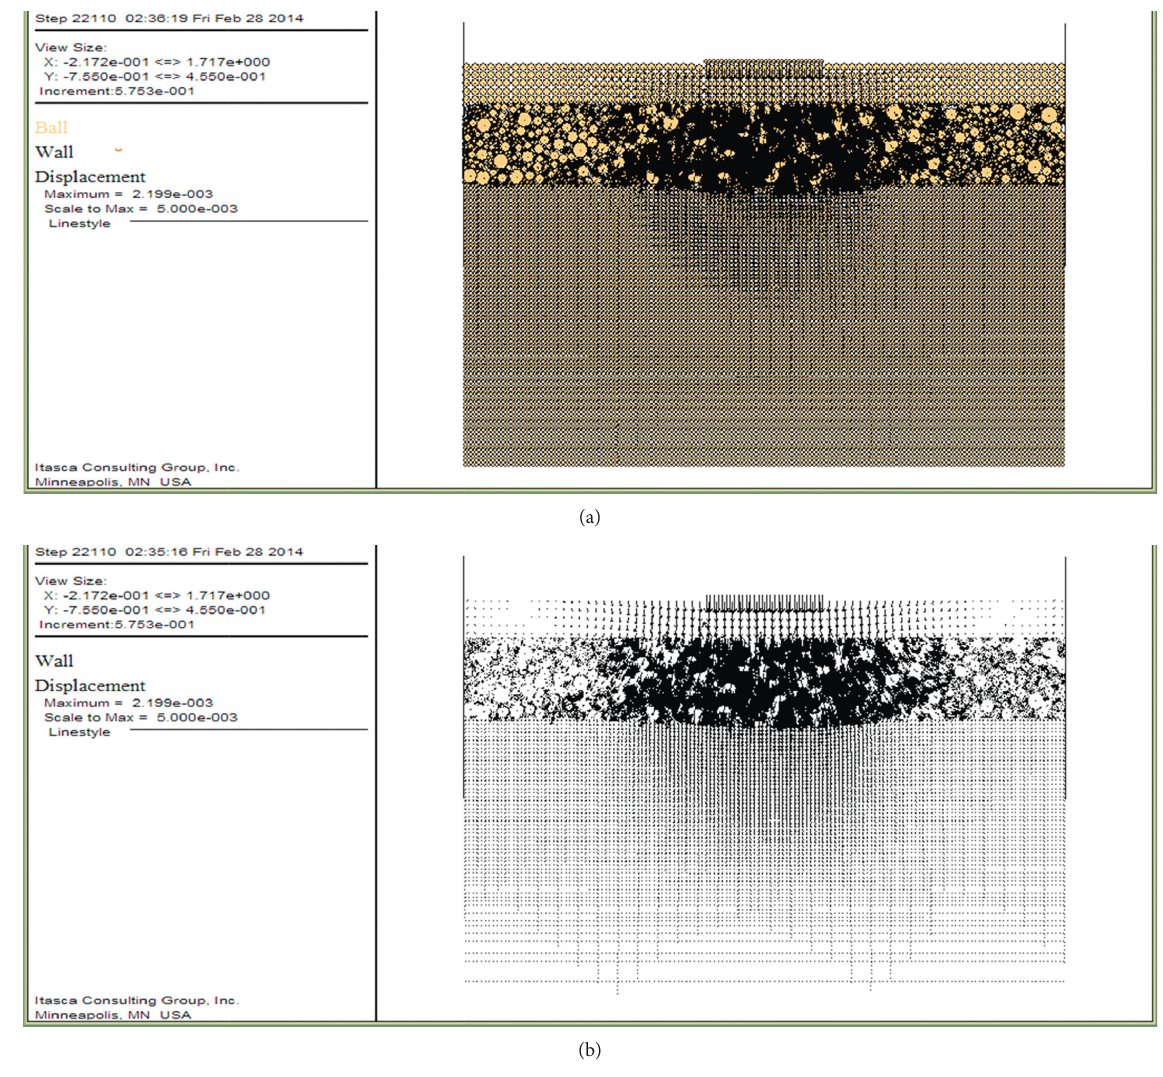
Figure 7: Particle displacement vector for each